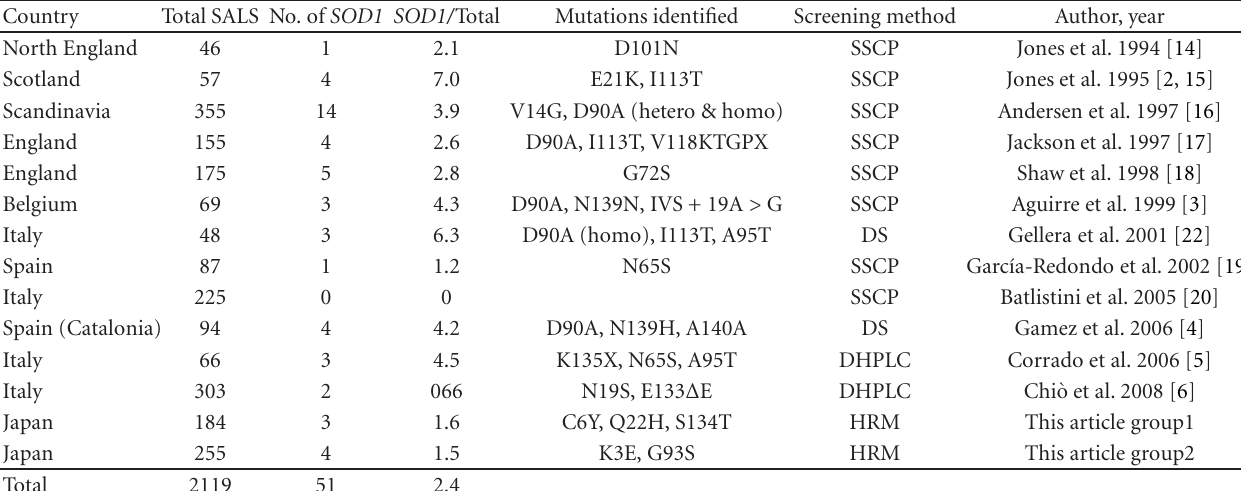
Table 2: SOD1 mutations in SALS patients of the di ff erent